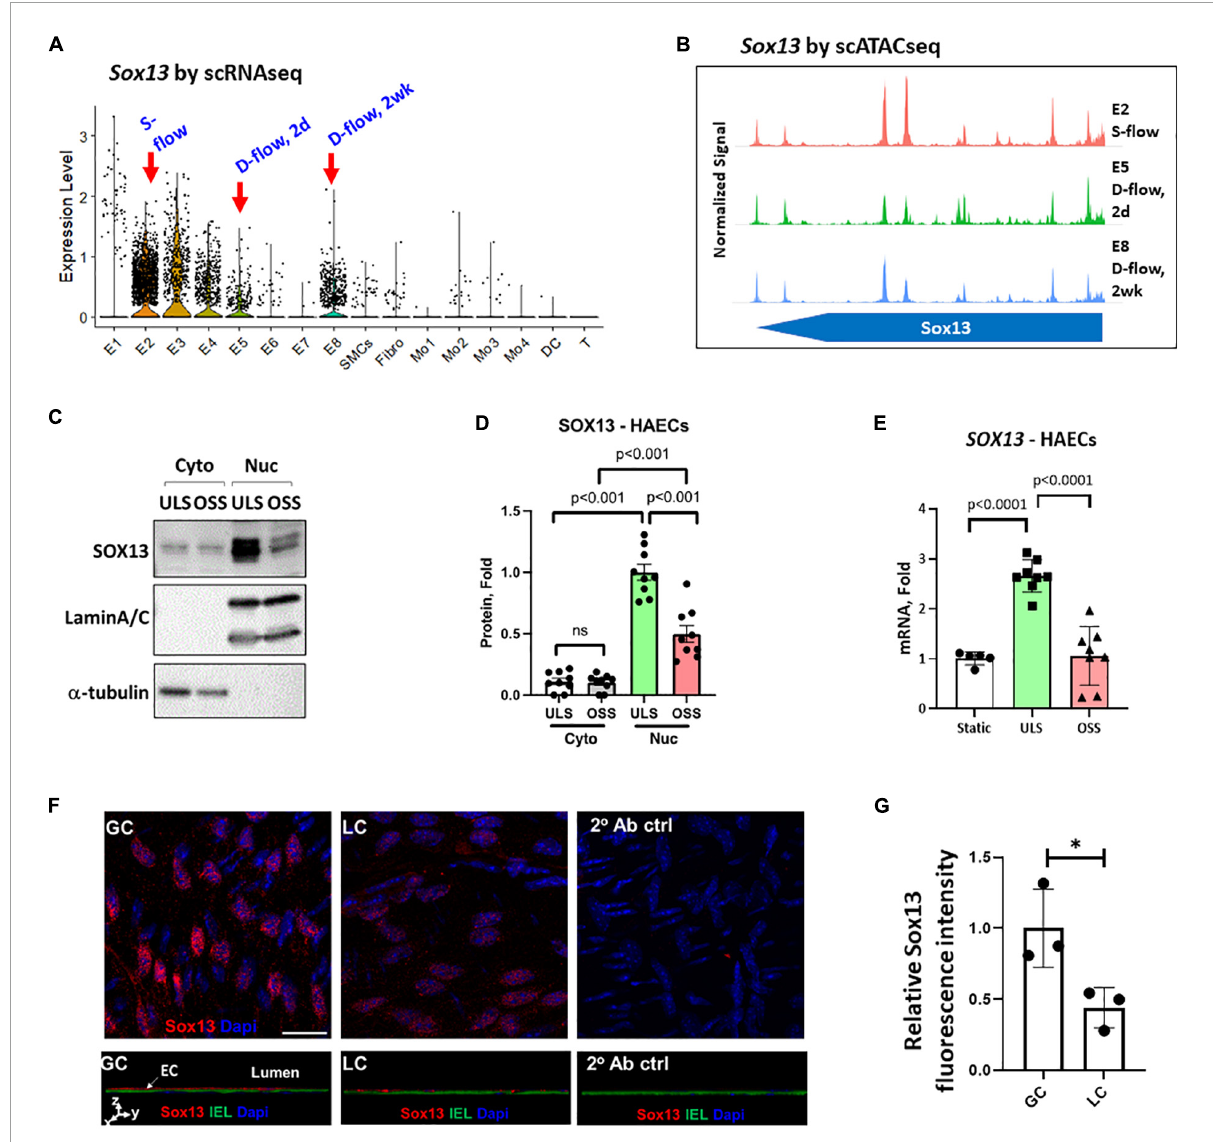
FIGURE2 Validation of SOX13 flow sensitivity in ECs. (A) Violin plot shows SOX13 expression profile in our published scRNAseq data obtained from the mouse LCAs and RCAs at the 2-day (acute) or 2 weeks (chronic) post-PCL (partial carotid ligation) surgery. E2 represents a healthy EC cluster exposed to s-flow in RCA. E5 and E8 are EC clusters exposed to acute and chronic d-flow, respectively. (B) Chromatin accessibility plot of Sox13 gene was obtained by re-analyzing the published scATACseq data using the same mouse PCL model. E2 (s-flow), E5 (acute d-flow), and E8 (chronic d-flow) show a time-dependent closure of SOX13 accessibility by d-flow in ECs. (C–E) HAECs exposed to ULS or OSS for 24 h were lysed, fractionated into the cytoplasmic (cyto) and nuclear (nuc) fractionations, and western blot analyzed using antibodies to SOX13, laminA/C, and α -tubulin (C) and quantified (D) . Mean ± SEM, n = 5, p -values calculated by student’s t -test. (E) Shows SOX13 qPCR from a similar HAEC shear study, Mean ± SEM, n = 8, p -values calculated by student’s t -test. (F) Shows immunofluorescence staining of Sox13 of mouse GC (greater curvature exposed to stable flow) and LC (lesser curvature exposed to disturbed flow) naturally in the aortic arch. The bottom panels show orthogonal views, showing SOX13 expression above the internal elastic lamina (IEL). DAPI shows nuclei. (G) Shows the quantitation of SOX13 expression. Mean ± SEM, n = 3 mice, p ≤ 0.05 by student’s t -test.